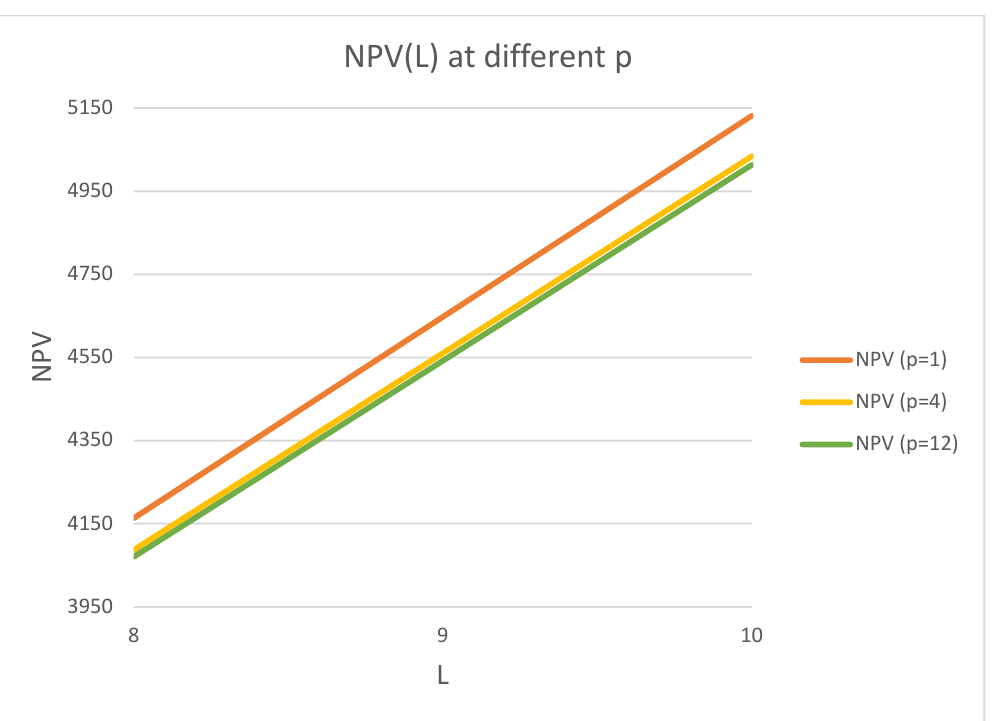
Figure 13. Change of net present value, NPV, with leverage, L , for k d = 0.14, k 0 = 0.22, and p = 1, 4, and 12, for a 3-year project ( n = 3) (larger scale).